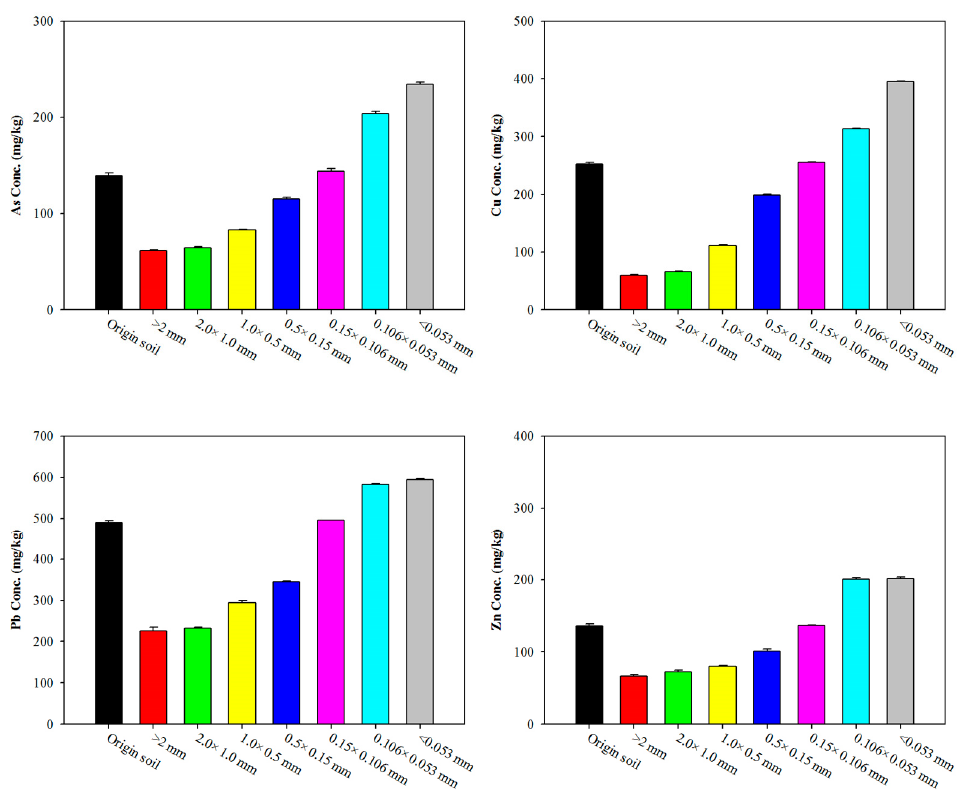
Figure 3. Concentration distribution of As, Cu, Pb, and Zn according to particle size.